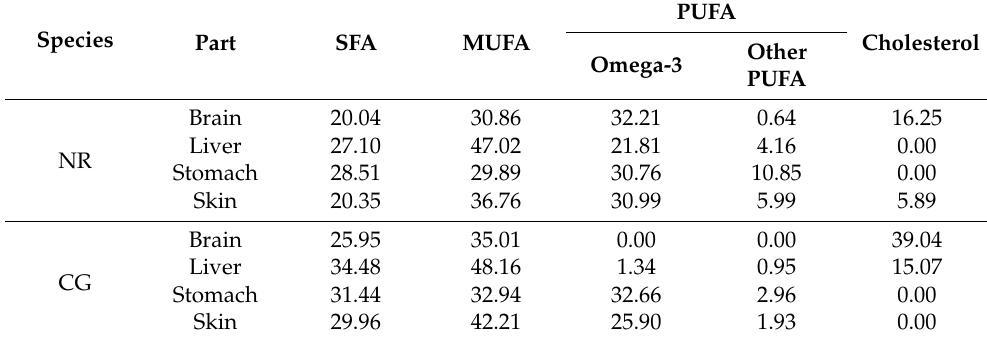
Table 1. Total FA and cholesterol contents (%) of different organs of N. rossii and C. gunnari .